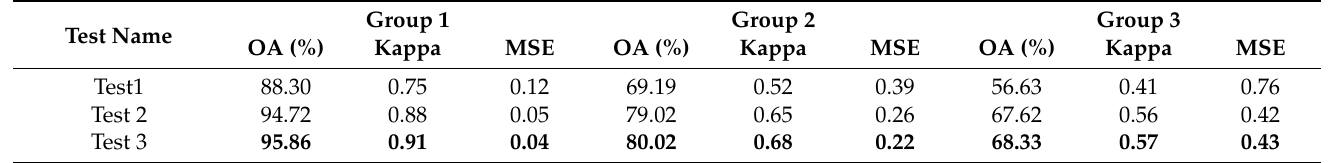
Table 13. Impact of historical data on the refined assessment of building damage.